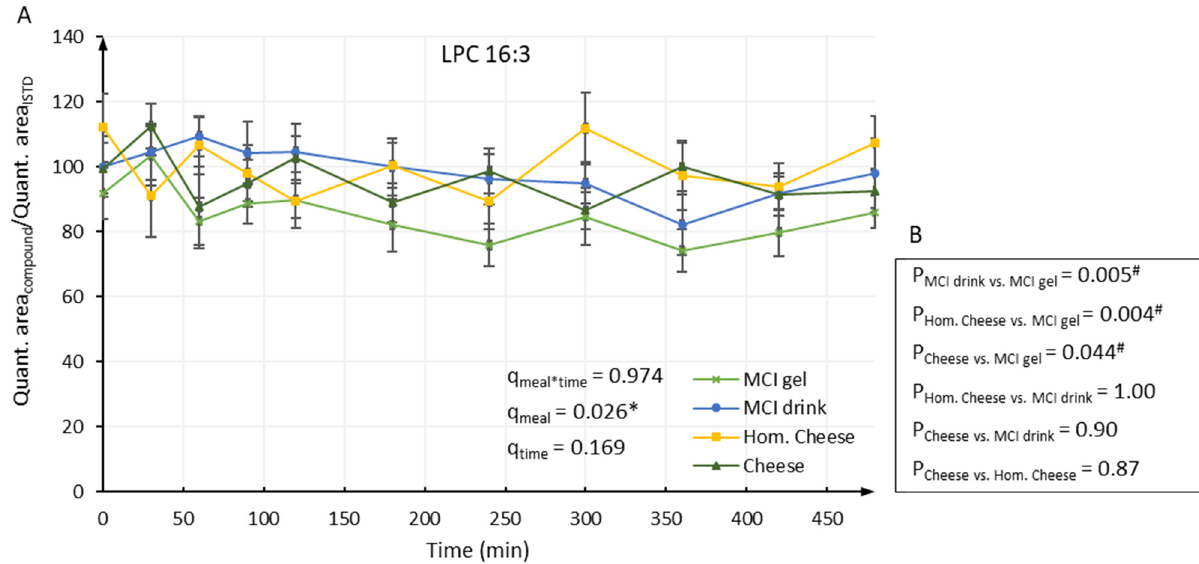
Figure 2. ( A ) Relative level of LPC 16:3 in plasma samples. Data were analyzed by repeated measures using a linear mixed model. Overall participant and within-visit participant differences were included as random factors and the analyses were adjusted for BMI, age and visit. q -values indicate FDR-adjusted p -values for meal–time interactions (q meal * time ), the effect of meal (q meal ) and the effect of time (q time ). * indicate significant differences ( q < 0.05). ( B ) p -values obtained from Tukey’s all-pairwise comparison conducted when a significant meal effect was observed in repeated measures analysis. # indicate significant differences ( p < 0.05).